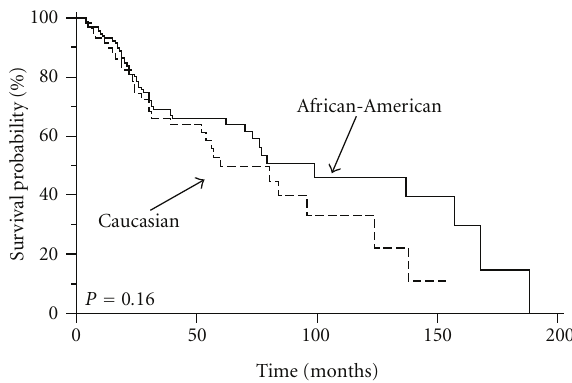
Figure 1: E ff ect of race/ethnicity on disease-free survival for 202 patients with triple-receptor negative breast cancer: shown is the DFS for 202 African-American and Caucasian patients with TNBC as described in section 2. The 5-year DFS was 66% for African- American women and 50% for Caucasian women ( P = 0 . 16).